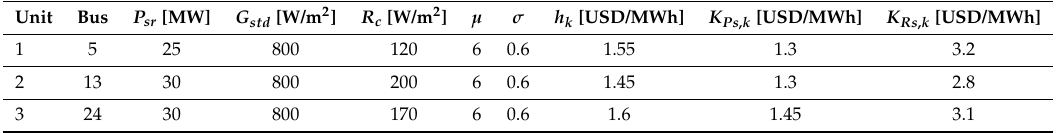
Table A3. Data for solar PV plant for IEEE 30-bus Modified (1).